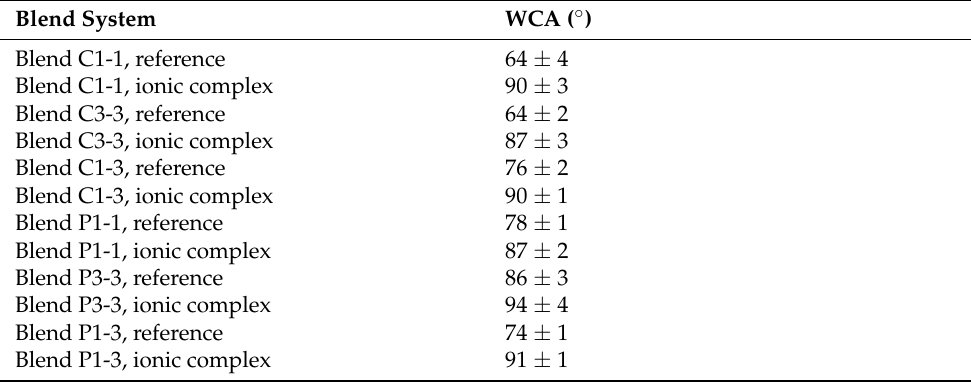
Table 4. Contact angle measurements for reference and ionic complex films.